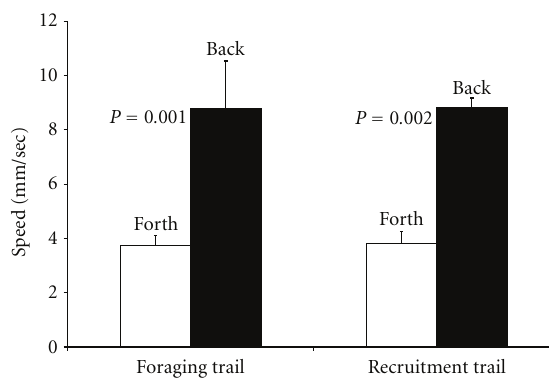
Figure 1: Mean travel speed ( ± SD) by trail-laying workers of Coptotermes gestroi in a glass tube connected to empty arenas (foraging trail) or wood (recruitment trail). N = 20; P values above bars correspond to the Wilcoxon matched-pairs test ( P < 0.05) for di ff erences between forth and back speed.